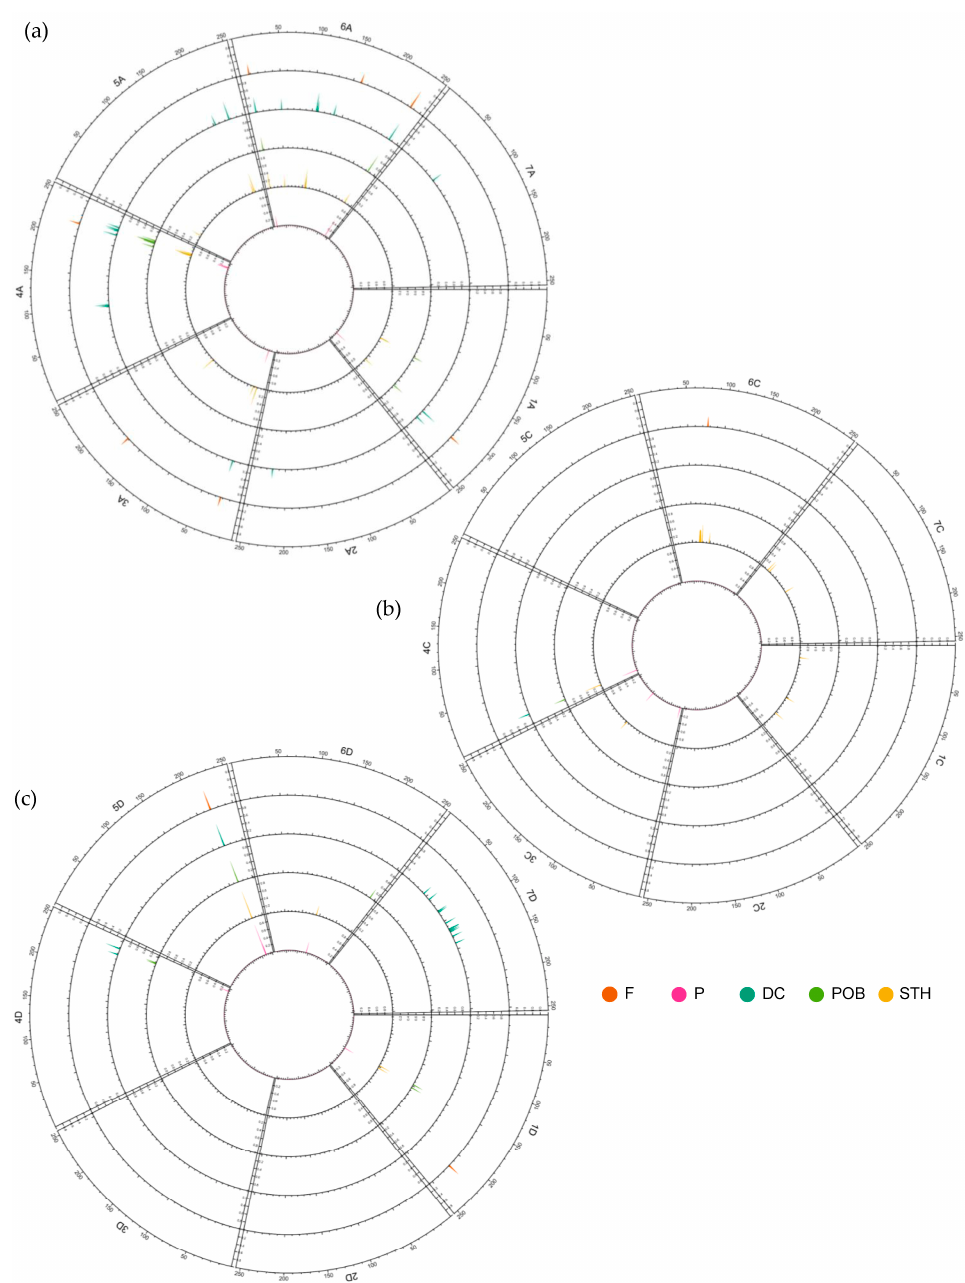
Figure 9. Circular overview of A. sativa chromosomes with an indication of the FST values for historic cultivars vs. other groups. ( a ) A genome chromosomes, ( b ) C genome chromosomes, ( c ) D genome chromosomes. DC—materials from DANKO Plant Breeding Ltd.; F—foreign modern cultivars; P—Polish modern cultivars; POB—materials from Małopolska Plant Breeding Ltd.; and STH—materials from Strzelce Plant Breeding